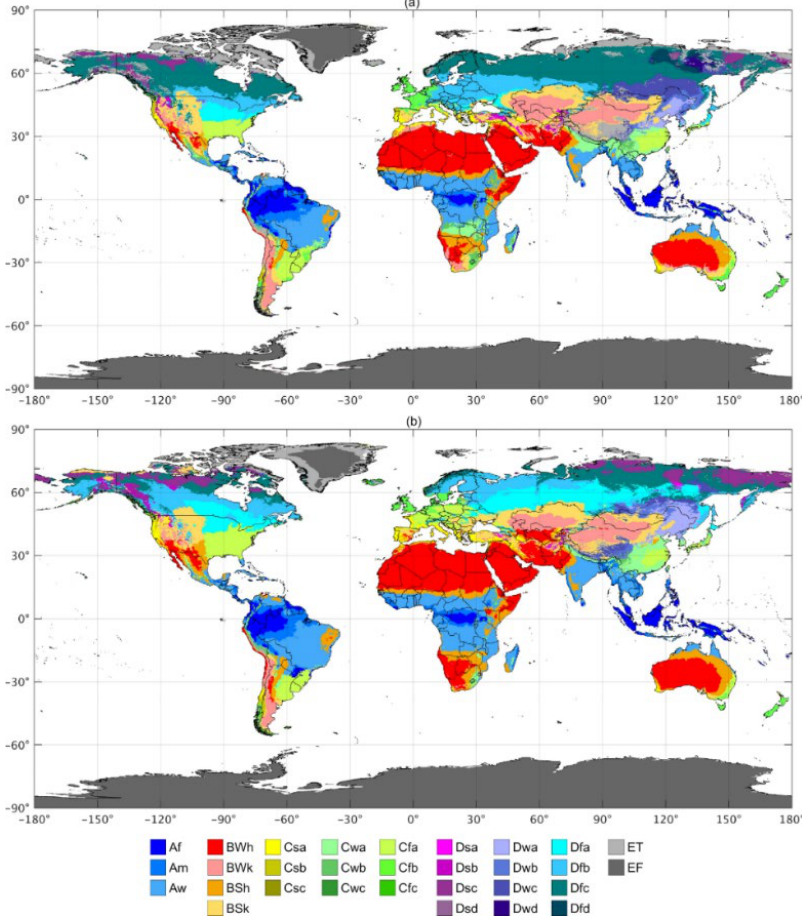
Figure 4. Update, presented by Hylke E. Beck et al. [46], on the climate classification maps of Köppen–Geiger. ( a ) displays the current map for between the years 1980 and 2016 and ( b ) the projections for the years 2071 to 2100.